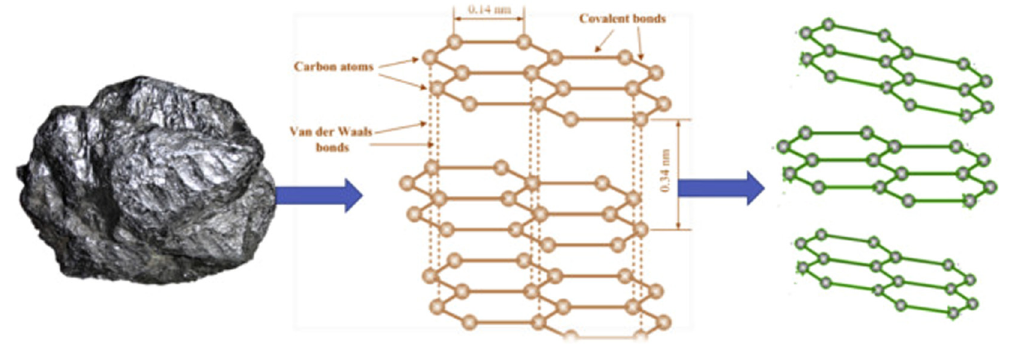
Figure 1: Schematic depictions about the origin ( presenting the transformation ) of graphene from graphite and peculiar structure of graphite and graphene. Reproduced from [ 58 ]